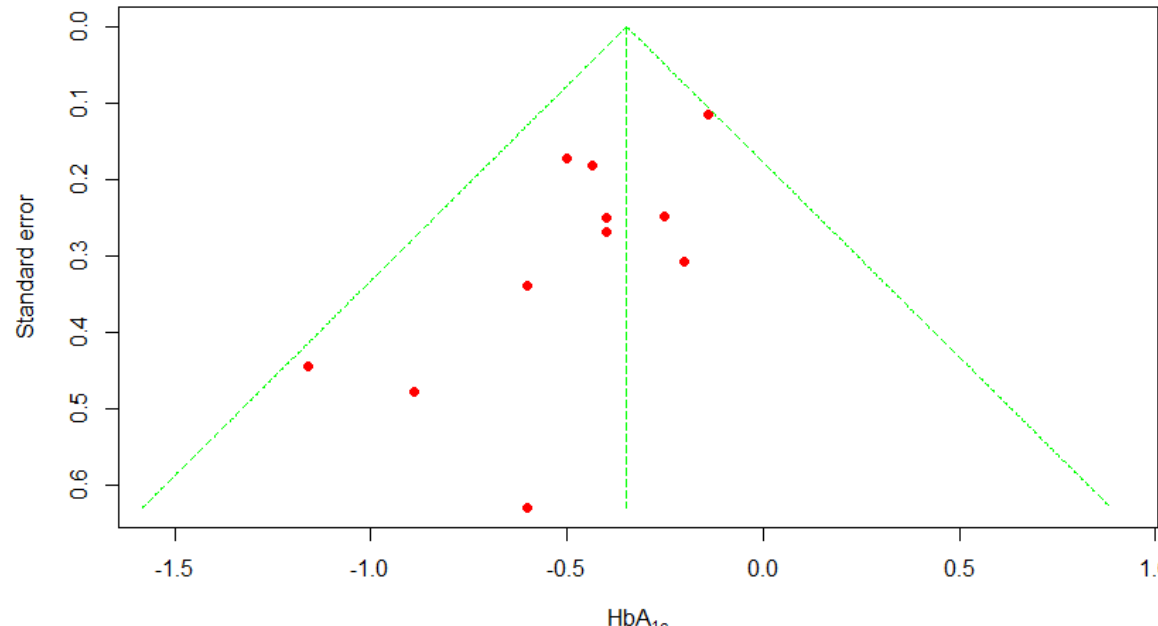
Figure 6. Funnel plot of publication bias. HbA 1c : glycated